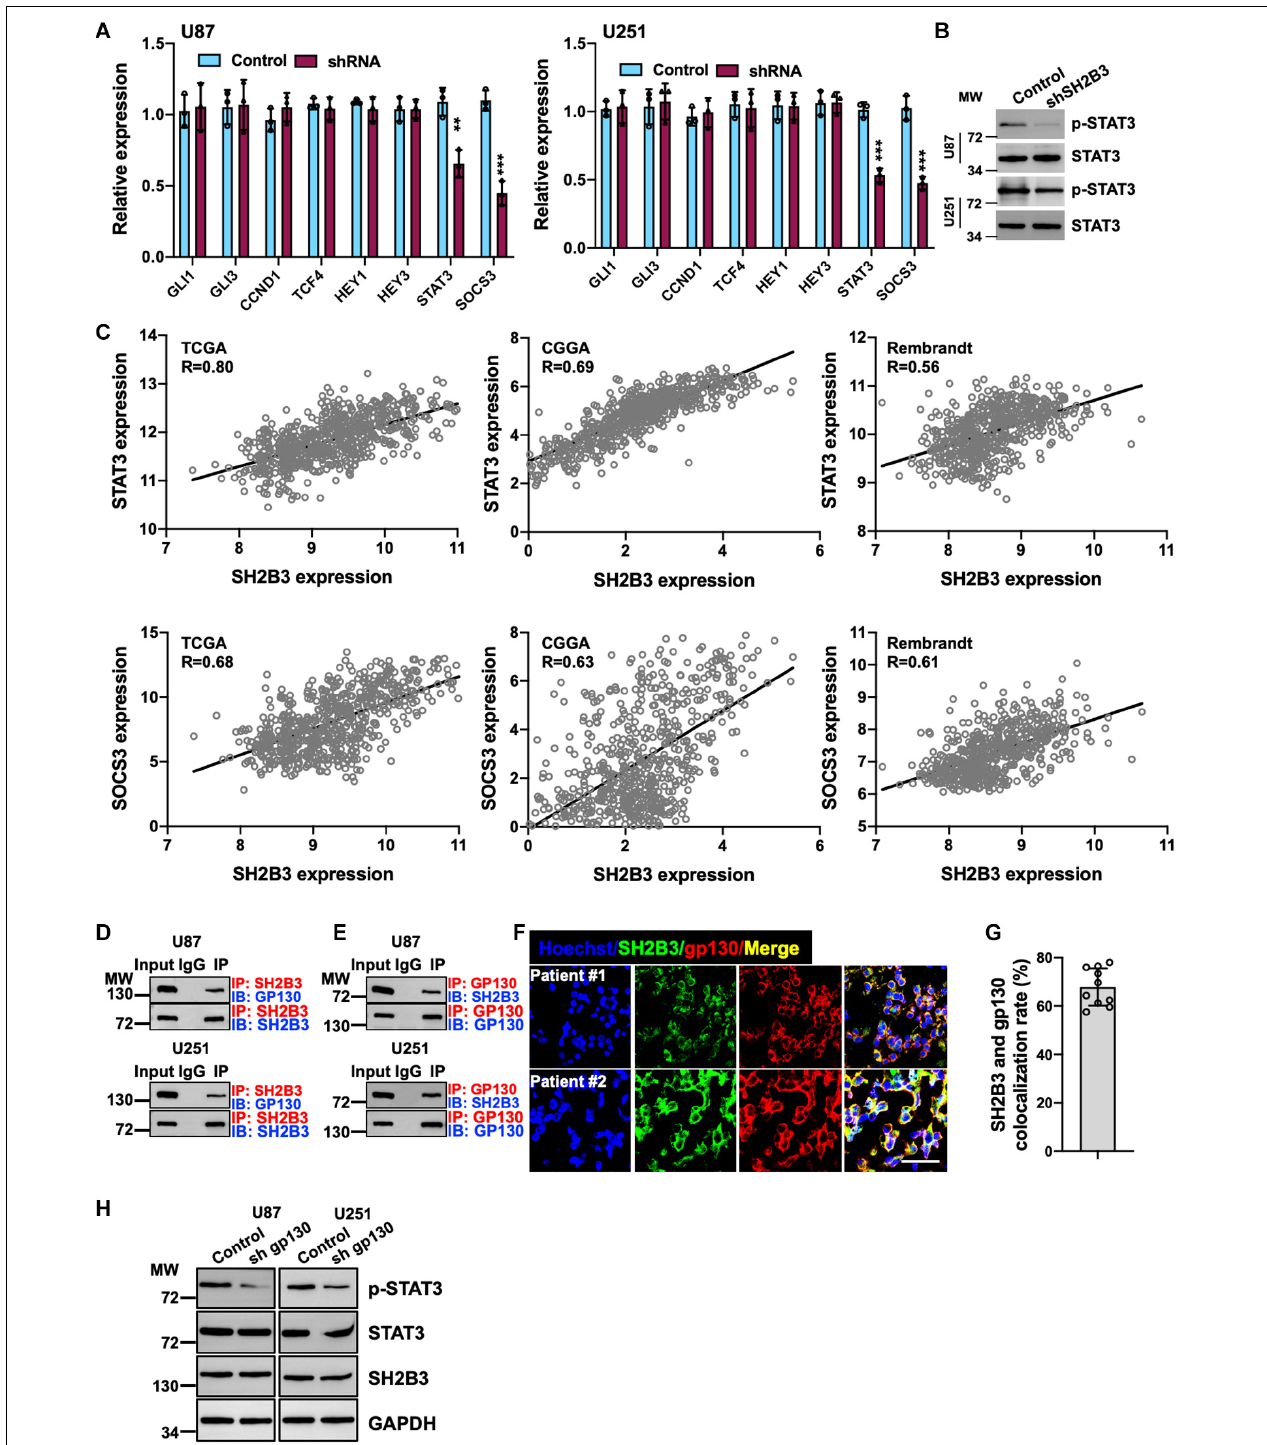
FIGURE 6 | Silencing of SH2B3 inhibits STAT3 activation. (A) Target genes of STAT3 were dramatically decreased after silencing of SH2B3 in U87 (left panel) and U251 (right panel) cells. (B) Western blot of phosphorylation form of STAT3 (Y705). (C) SH2B3 mRNA expression was positively correlated with STAT3 target gene in indicated data sets. (D) SH2B3 physically binds to gp130. (E) Gp130 physically binds to SH2B3. (F) Representative images of co-immunofluorescence staining between SH2B3 and gp130 in patient-derived clinical specimens. Scale bar = 50 µ m. (G) Quantification data for panel (F) . (H) Silencing of gp130 significantly attenuates p-STAT3 (Y705) expression. *, **, and *** indicate p < 0.05, p < 0.01, and p < 0.0001, respectively.